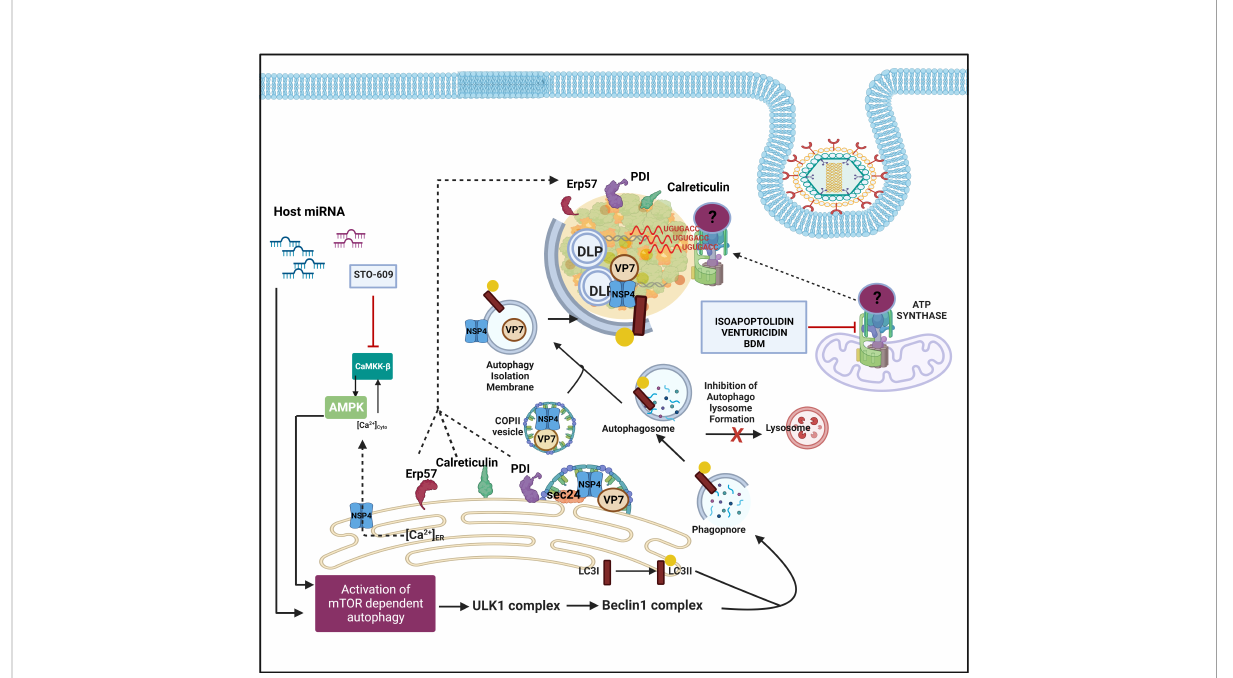
FIGURE 5 Host cellular contribution in the later events of viroplasm dynamics. Many ER chaperone proteins such as Erp57, PDI, and Calreticulin translocate near RV viroplasms. PDI and Calreticulin foster RV morphogenesis. In RV infected cells, mTOR inhibition and the autophagic signalling are induced by host microRNA-dependent mechanism and also via NSP4-Ca2+-Calmodulin-CaMKK b -AMPK pathway. Overall, mTOR restriction causes de-repression of the ULK1 complex which subsequently forms phagophore through Beclin1 complex activation and LC3 II lipidation. However, autophagosomes are prevented from lysosomal targeting in RV infected cells; instead, they are utilized for carrying the RV proteins NSP4 and VP7 coming out with the ER-derived COP-II vesicles to maturing progeny virions within viroplasms, thereby aiding in